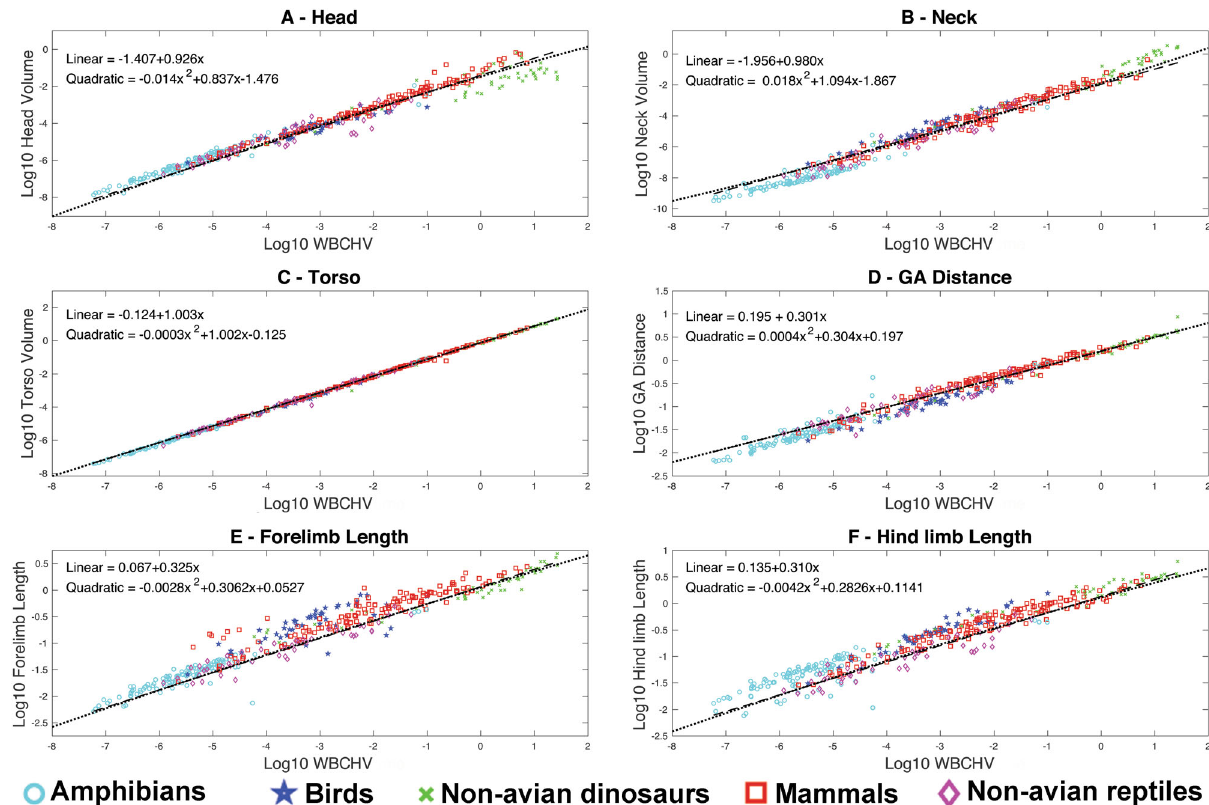
Fig. 2 | Scaling of major body segments in tetrapods. Scaling relationships betweenmajor body segment size and overall bodysize (totalwhole-bodyskeletal convex hull volume, WBCHV) in 410 terrestrial tetrapods using phylogenetically- informed linear (thick dashed lines) and quadratic (thin dotted lines) fi ts (Hypotheses1-2).The A head, B neckand C torsoarerepresentedbyvolumes,while D gleno-acetabular (GA) distance, E total forelimb and F total hind limb size is